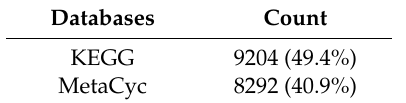
Figure 2. Example aromatic substructure that cannot be detected by Indigo. Table 4. Compounds with aromatic substructure.